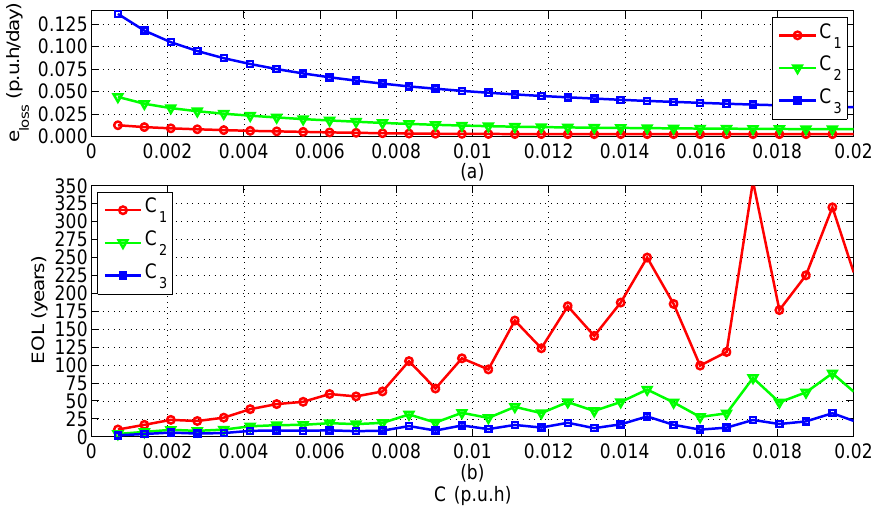
Figure 20. BESS sizing results for SING case considering a whole year of transient results data, values of f 1 at 52, 51 and 50.5 Hz, C 1 , C 2 and C 3 respectively: ( a ) Daily energy losses ( e loss ) per BESS capacity; and ( b ) end of life (EOL) per BESS capacity.